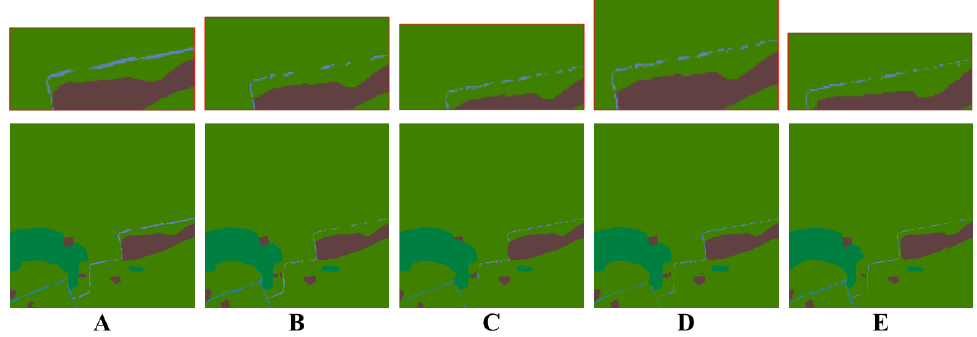
Figure 10. Visualization of segmentation results. ( A ) our model; ( B ) UNet; ( C ) PSPNet; ( D ) HRNet; ( E ) DeepLab.